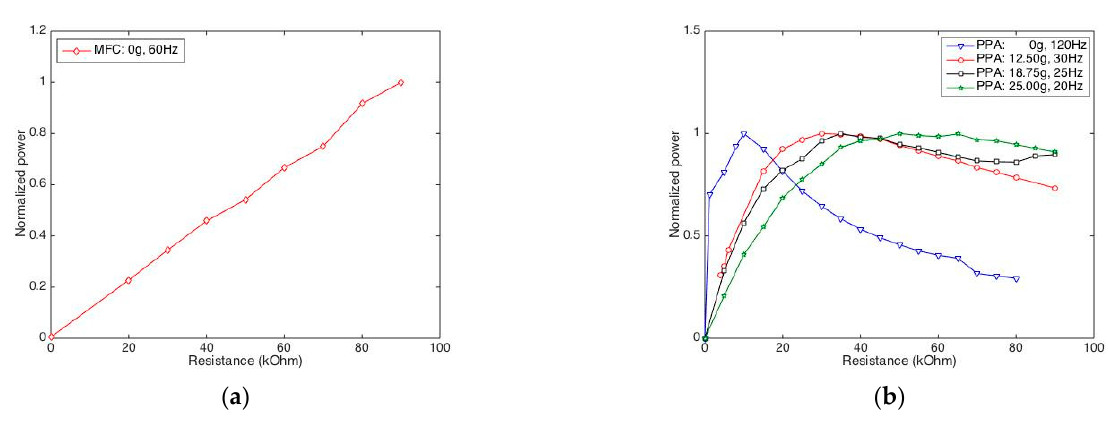
Figure 8. Normalized-harvested powers by varying load resistances for MFC and PPA. ( a ) Power vs. resistance for MFC; ( b ) Power vs. resistance for PPA.